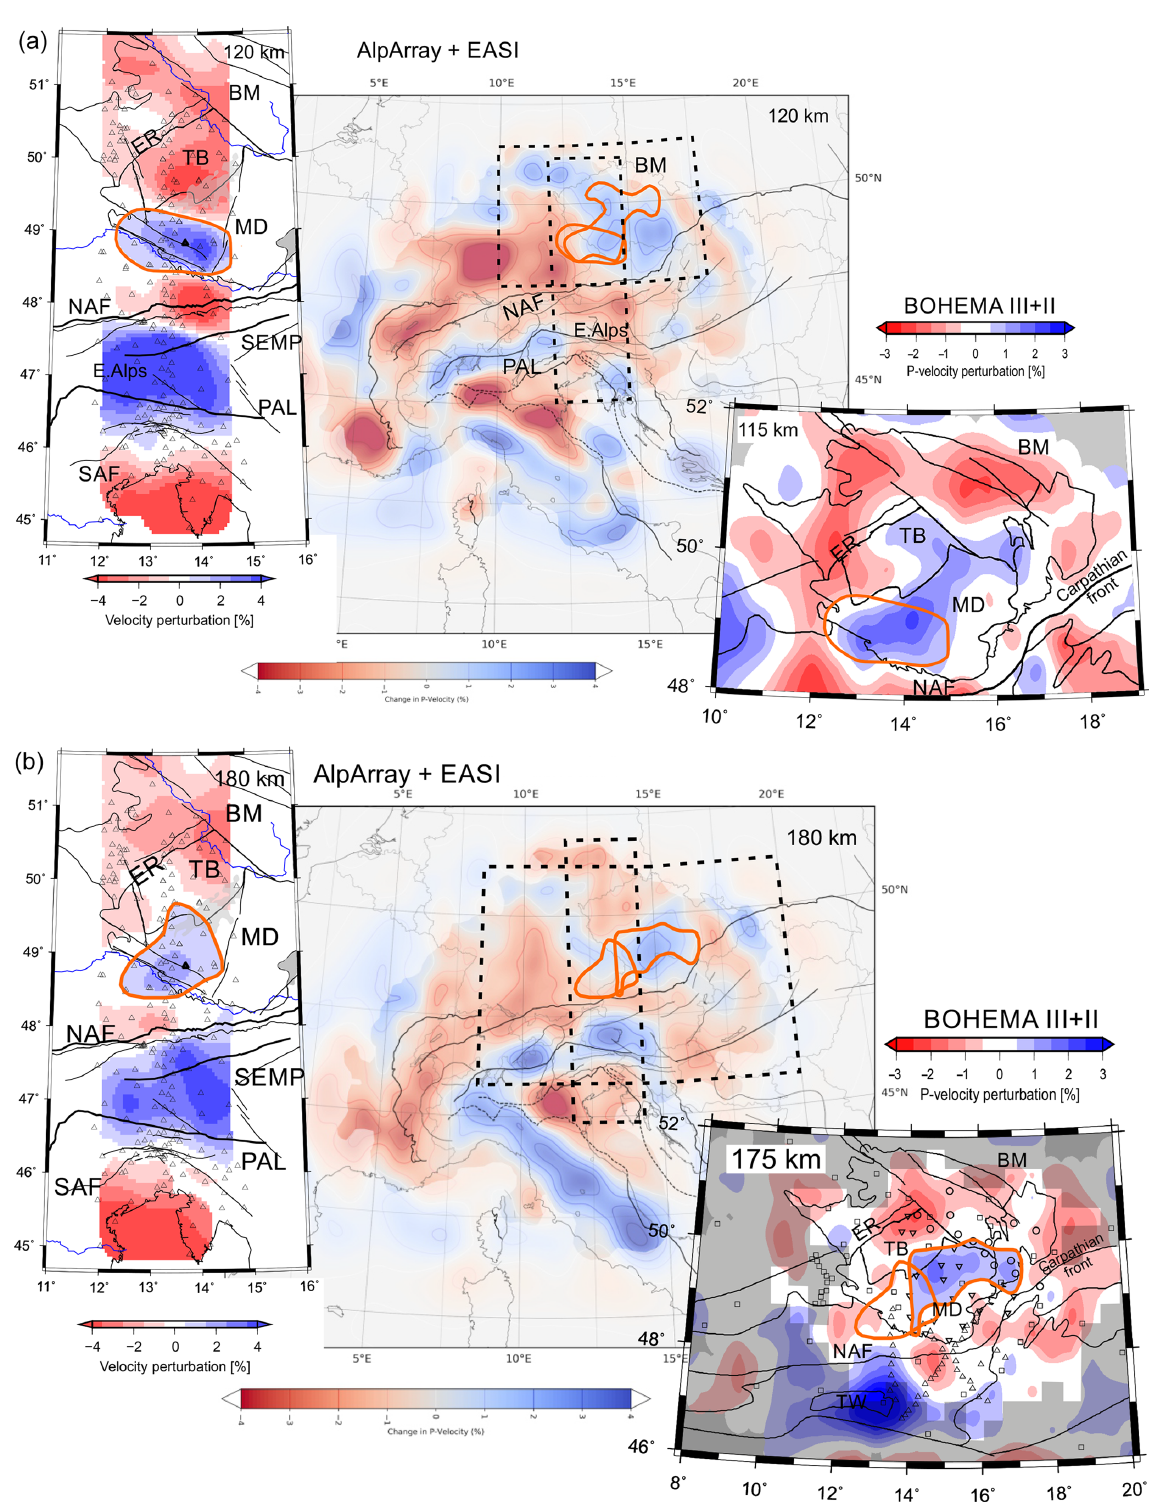
Figure 6. Horizontal slices at 120 (a) and 180km (b) depths through the velocity perturbation model EASI-AA (left) (this paper), the model by Karousová et al. (2013) (right), and the model by Paffrath et al. (2021, this issue) (centre), on which the HV-BM from the other two models is marked by orange contours. Labels are as in Fig.